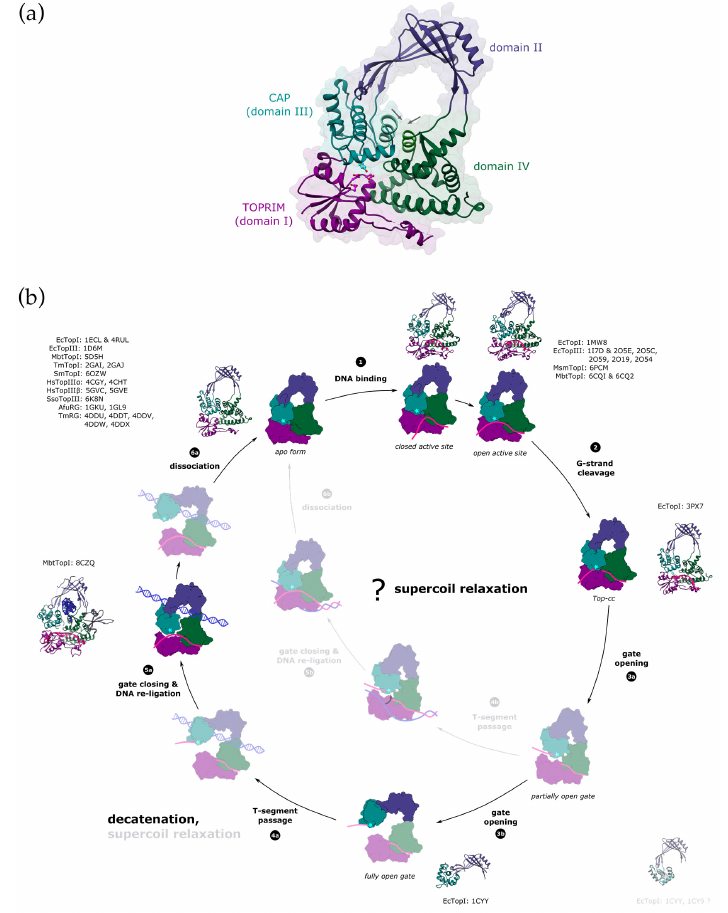
Figure 3. Proposed reaction mechanism of type IA enzymes. ( a ) Domain organisation of type IA topoisomerases. Type IA topoisomerases consist of four domains (labelled I–IV). CAP and TOPRIM domains contain the active site (the catalytic Tyr is shown in cyan and the residues from the TO- PRIM motif are shown in magenta), and they also form the DNA-gate. The interface alpha-helices in domains DIII and DIV that are closing the entrance into the toroid hole are labelled with arrows. PDB ID: 1ECL. ( b ) Topo IA catalytic cycle. Structurally characterised intermediates are shown in full colour with the crystal structures and the PDB accession codes next to them (EcTopI = Escherichia coli topoisomerase I, EcTopIII = Escherichia coli topoisomerase III, MbtTopI = Mycobacterium tubercu- losis topoisomerase I, TmTopI = Thermotoga maritima topoisomerase I, SmTopI = Streptococcus mutans topoisomerase I, HsTopIII α = human topoisomerase III α , HsTopIII β = human topoisomerase III β , SsoTopIII = Sulfolobus solfataricus topoisomerase III, AfuRG = Archaeoglobus fulgidus reverse gyrase, TmRG = Thermotoga maritima reverse gyrase, MsmTopI = Mycobacterium smegmatis topoisomerase I). Domains I to IV are coloured in dark magenta, dark slate blue, dark cyan, and dark green. The